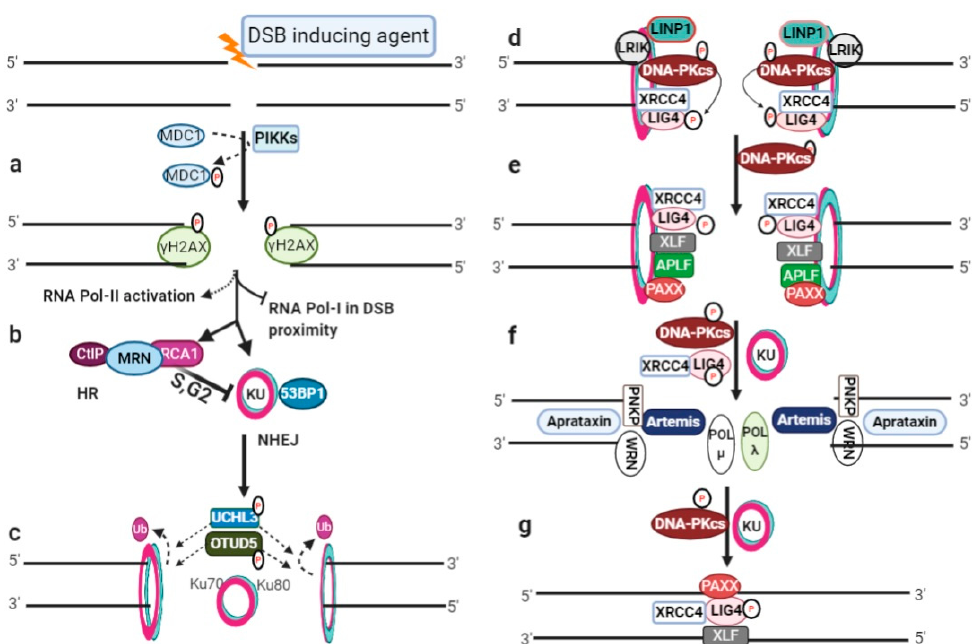
Figure 1. DSB induction and NHEJ repair pathway: ( a ) DSB initiates phosphorylation by activated phophotidylinositol-3 kinase-like kinases (PIKKs) and phosphorylation of H2AX ( γ H2AX) for cascade signaling; ( b ) RNA polymerase I-based local transcription inhibition in the DSB proximity, RNA polymerase II activation for damage-induced RNA generation, and the recruitment of NHEJ or HR repair machinery; ( c ) KU heterodimer binding at broken ends for NHEJ repair initiation and deubiquitylation of the Ku80 subunit; ( d ) DNA-PKcs autophosphorylates and then phosphorylates LIG4. LINP1 and LRIK are non-coding RNAs that stabilize the KU–DNA complex; ( e ) recruitment of XLF, APLF, and PAXX; ( f ) end processing by Artemis nuclease and other end processing mole- cules, and gap filling by polymerases; ( g ) LIG4 ligate-processed ends assisted with XRCC4, PAXX and XLF.